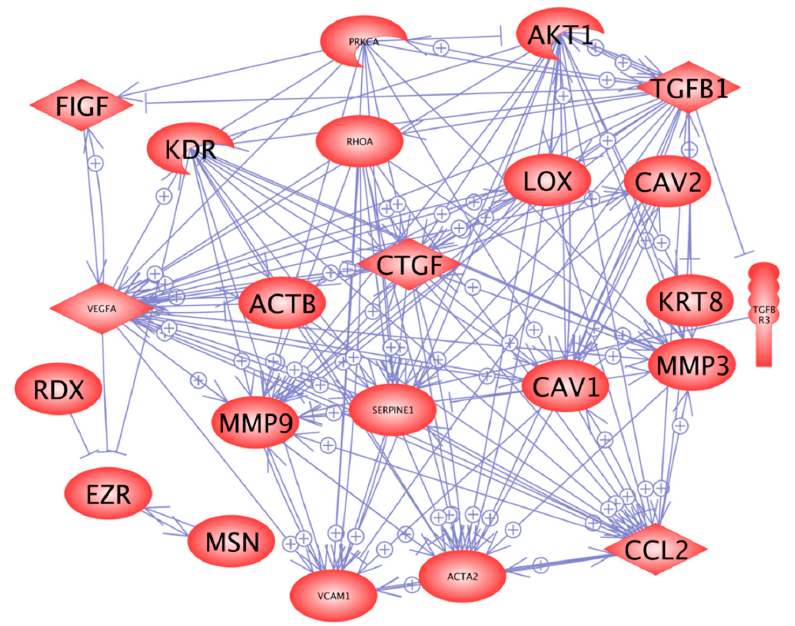
Figure 6. Mutual regulation network at gene expression level. FIGF -vascular endothelial growth factor D; KDR -kinase insert domain receptor; SERPINE1 -plasminogen-activator inhibitor-1.